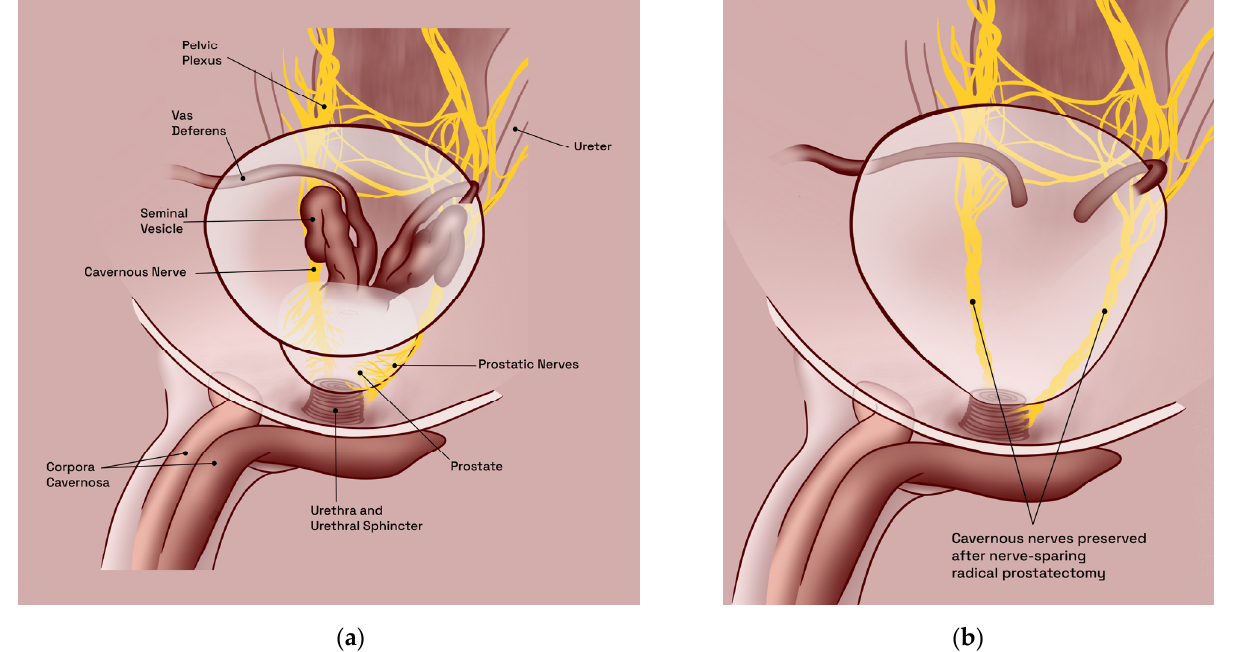
Figure 2. Comparative illustrations of male pelvic anatomy in humans, oblique view: ( a ) basic physiological layout; ( b ) post bilateral nerve-sparing radical prostatectomy. Illustrations adapted from Arthur L. Burnett [26].